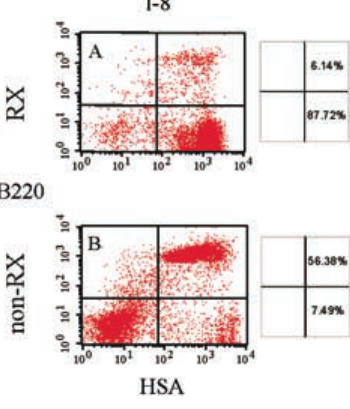
FIGURE 2 Reduction of the different B cell populations and accumulation of precursor cells in RX-P.S. following irradiation. Splenocytes were isolated from A, RX-P.S. and B, non-RX mice 8 days after primary immunization (A, B) with NP-KLH precipitated in Alum. B220 and HSA double positive and HSA high single-positive cells are defined to represent the different B cell populations and precursor cells,